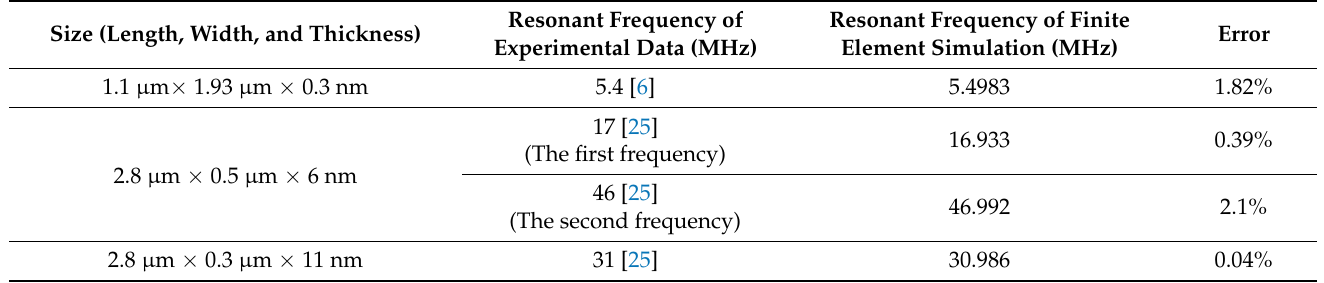
Table 2. Comparison of experimental data and finite element simulation. Size (Length, Width, and